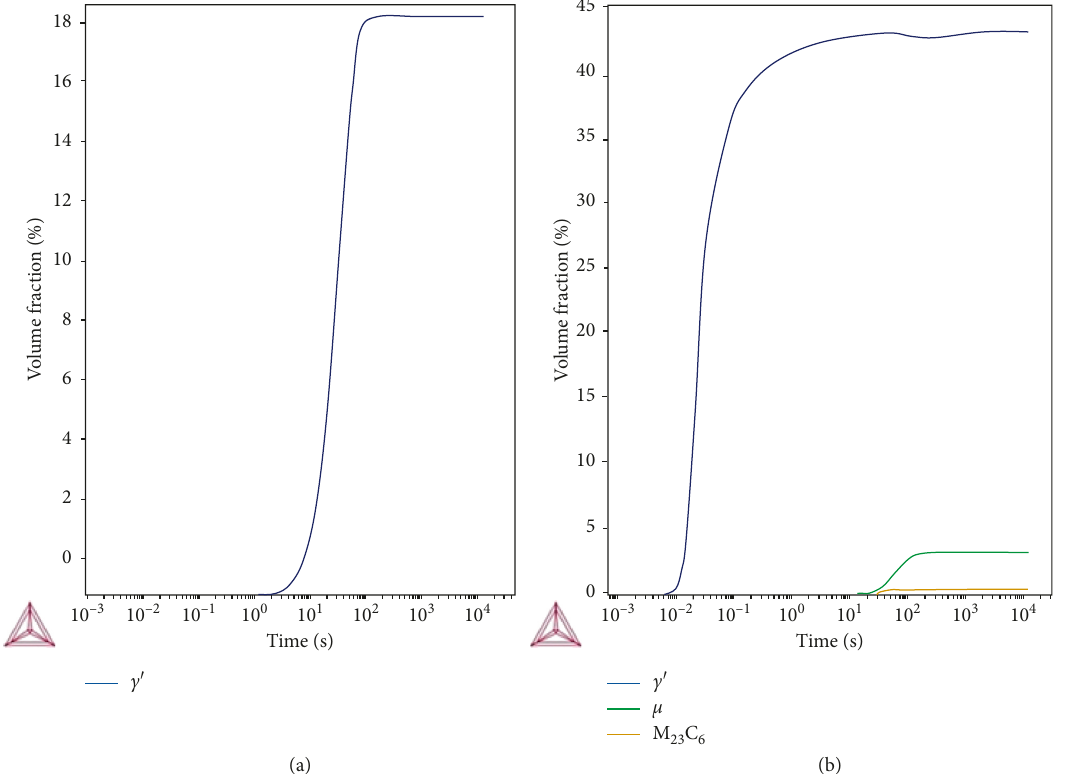
Figure 8: Volume fraction of precipitates versus time for the conditions of heat treatment of (a) isothermal aging until 1353K (1080 ° C) and (b) double isothermal aging until 1118K (845 °